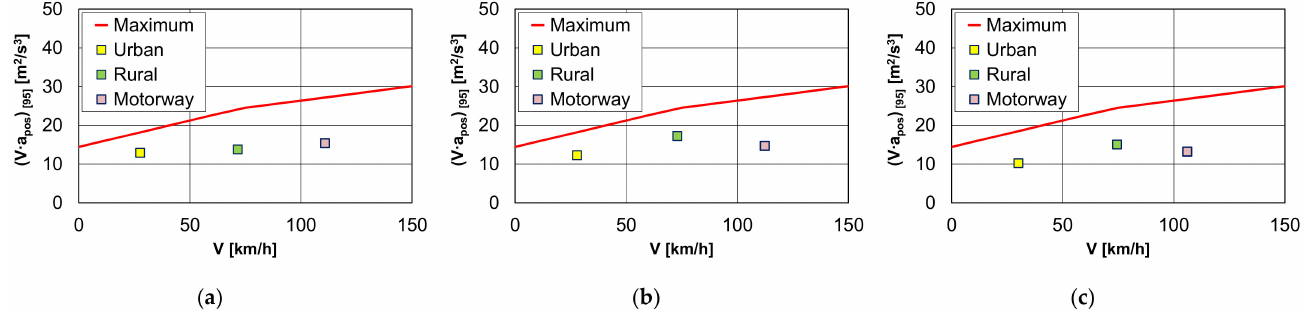
Figure 5. Evaluation of the dynamic conditions of the RDE test—the 95th centile (v · a pos )—for a passenger vehicle with a gasoline engine ( a ), diesel engine ( b ), PHEV ( c